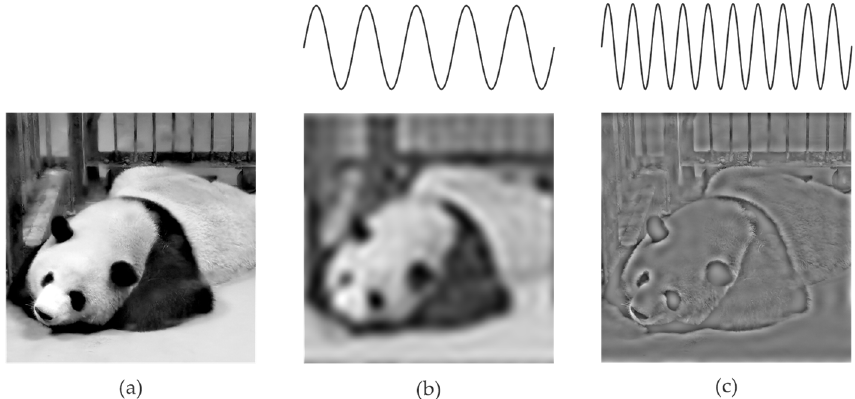
Figure 2. Natural images can be decomposed into a low and a high spatial frequency part. ( a ) Original picture; ( b ) low-frequency part; ( c ) High-frequency part.